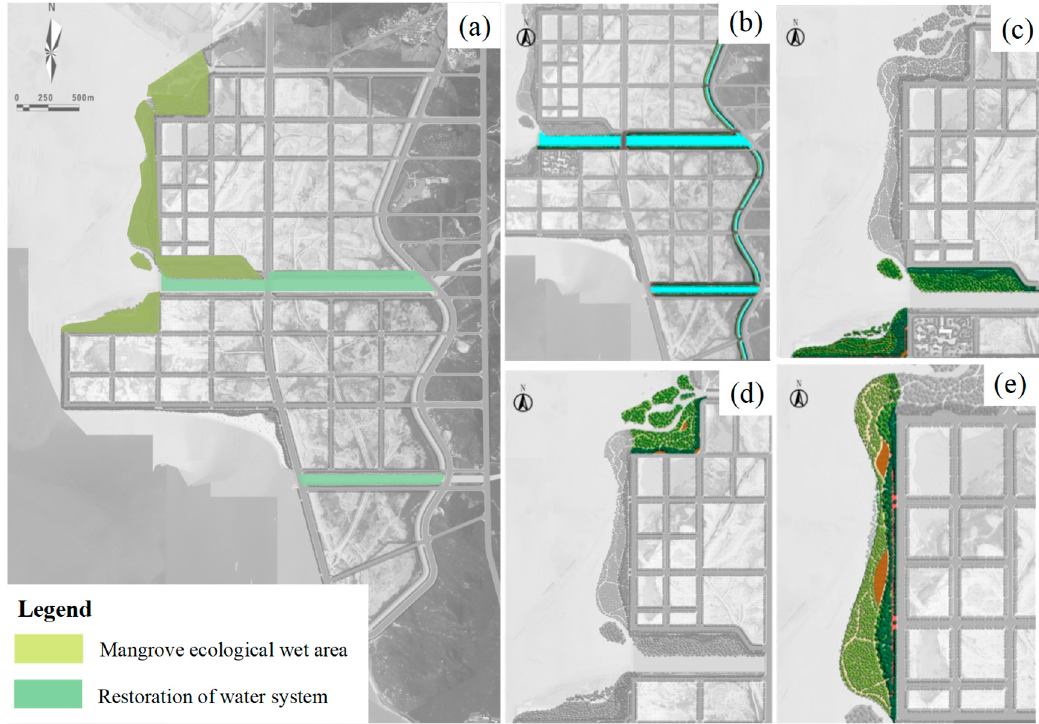
Figure 6. (a)The restoration schemes of wetland space; (b)Restoration of water system; (c) Mangrove Figure 6. ( a ) The restoration schemes of wetland space; ( b ) Restoration of water system; ( c ) Mangrove ecological wetland area outside the Dama River; (d)Mangrove ecological wetland area at north side ecological wetland area outside the Dama River; ( d ) Mangrove ecological wetland area at north side of of area C and(e) Mangrove ecological wetland area at west side of area C. area C and ( e ) Mangrove ecological wetland area at west side of area